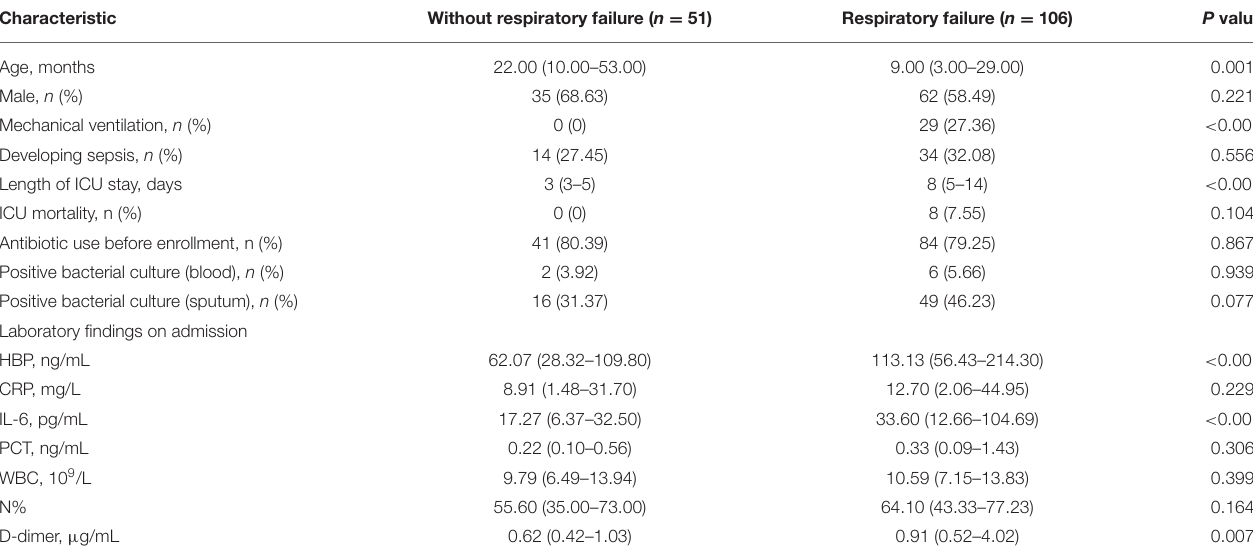
TABLE 1 | Characteristics of the study